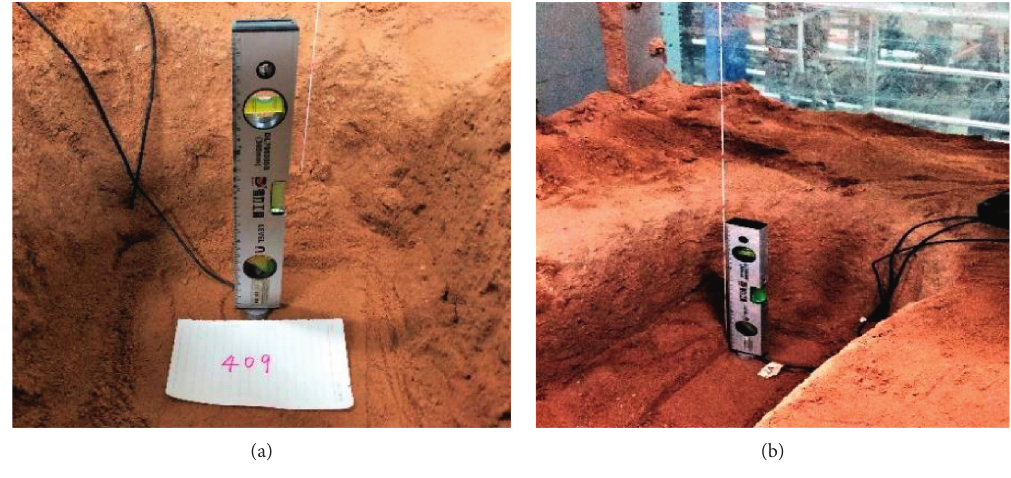
Figure 4: Burial diagram of Earth pressure box.